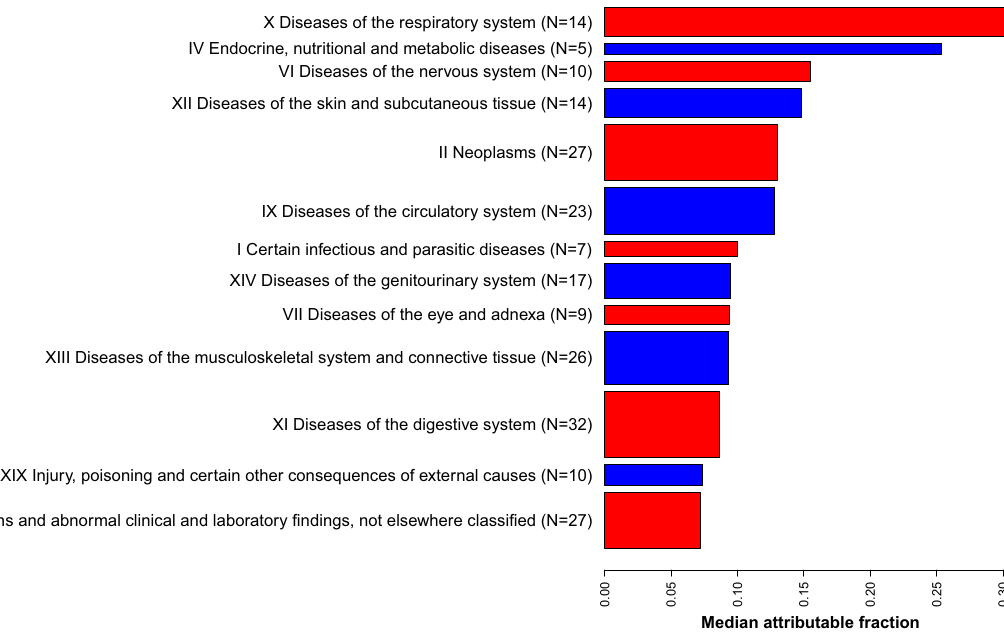
Figure 2. Median attributable fractions for each ICD-10 chapter with at least 5 diseases where A f > 0.2 . Bar widths are proportional to the number of diseases in each